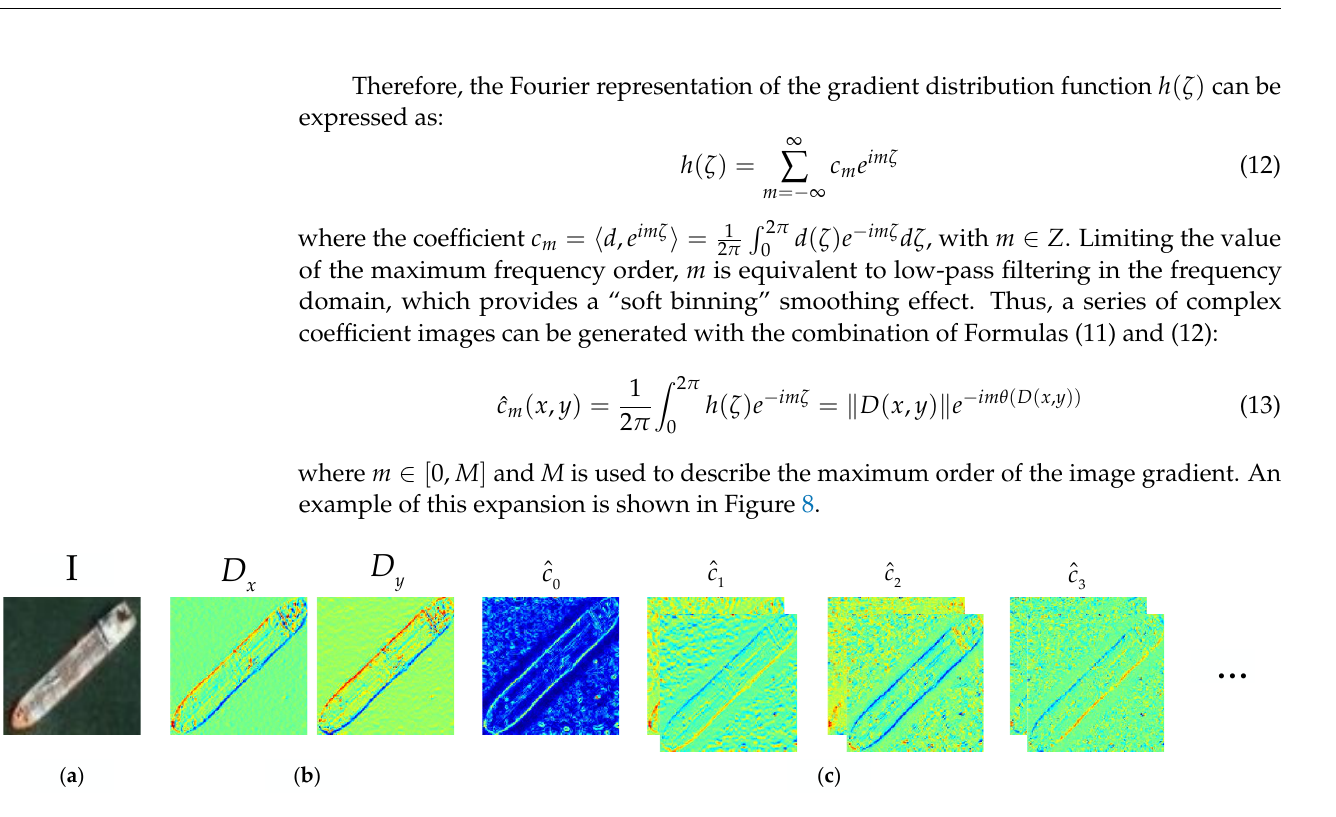
Figure 8. The illustration of the expansion of gradient images to Fourier coefficient images. ( a ) Input image; ( b )The gradient images; ( c ) The complex Fourier coefficient images.